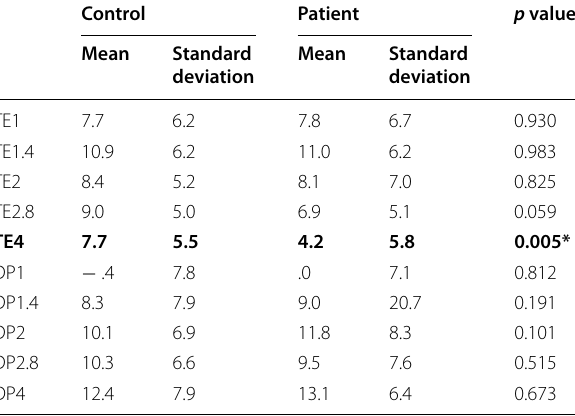
Table 3 Otoacoustic emissions test results in